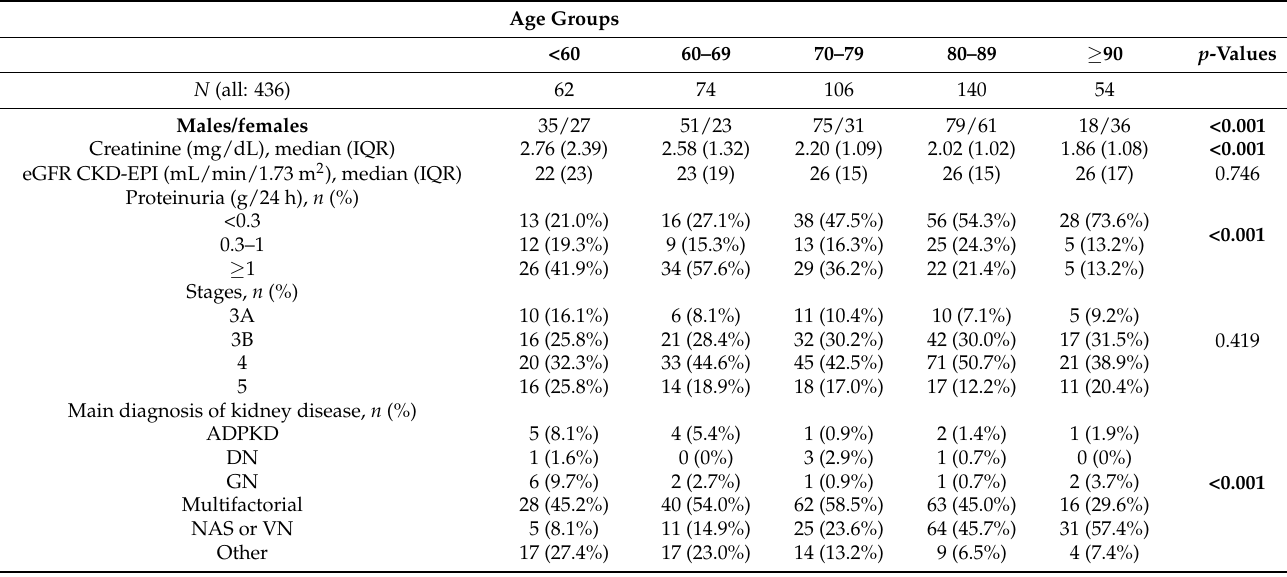
Table 1. Baseline data: the cohort followed-up at unit dedicated to advanced CKD (UIRAV) according to age